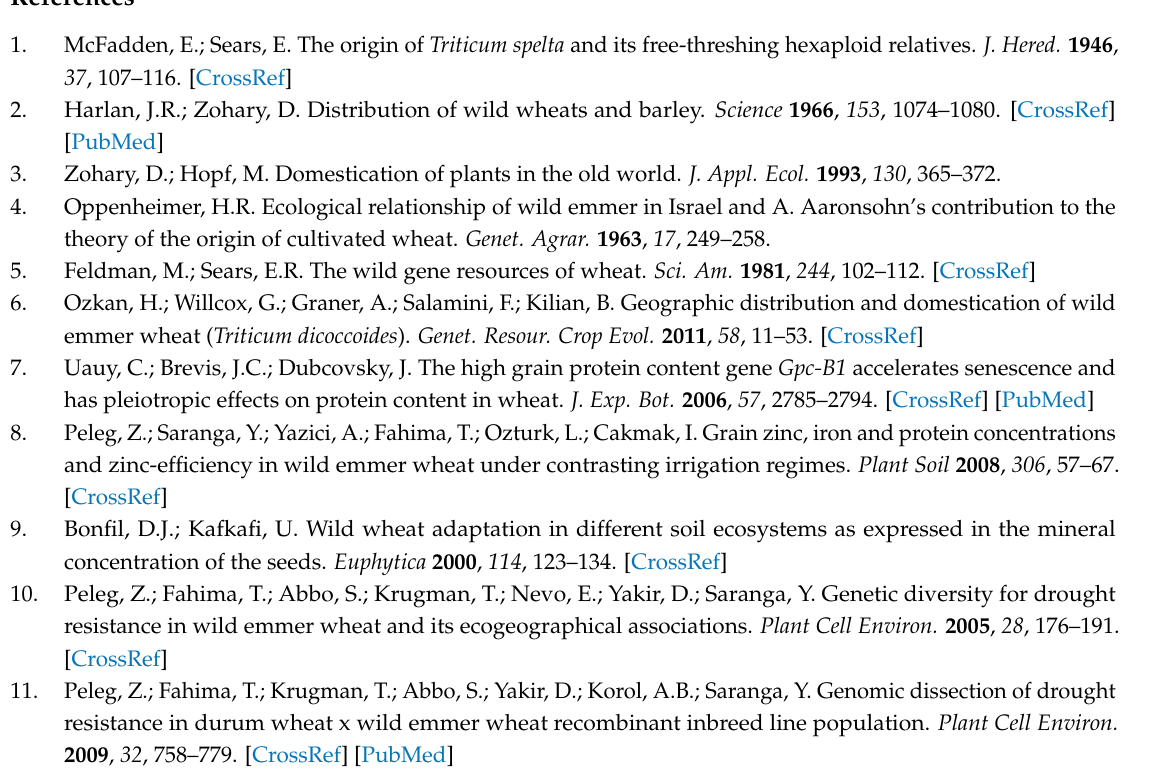
s1, Figure S1: Stripe rust resistance phenotype in T. dicoccoides accessions, Table S1: The presence/absence polymorphism of Yr15 and Yr36 genes and the reaction to stripe rust in populations of T. dicocciodes , Table S2: The geographical and climatological data for 57 collection sites, Table S3: Oligonucleotide primers used for screening of Yr15 and Yr36 genes in T. dicocciodes